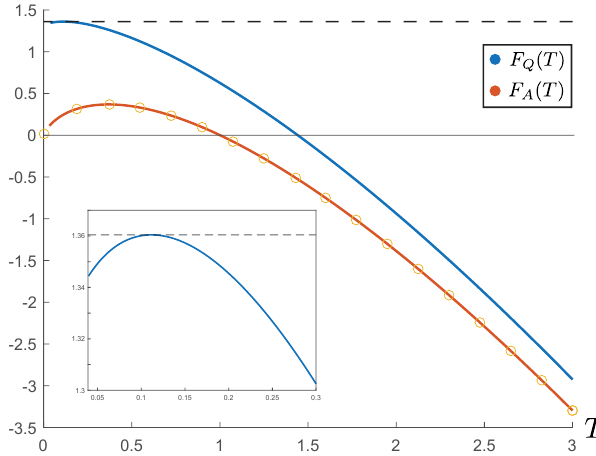
Figure 4. Quenched and annealed free energies of N = 1 CJ supergravity computed numerically from the sample of random matrices shown in figure 1, using the fourteen smallest magnitude eigenvalues of each matrix. The circled data shown in the plot corresponds to the analytic annealed free energy (3.25), agreeing perfectly with the numerical result. The inset shows the ultra-low temperature behavior of the quenched free